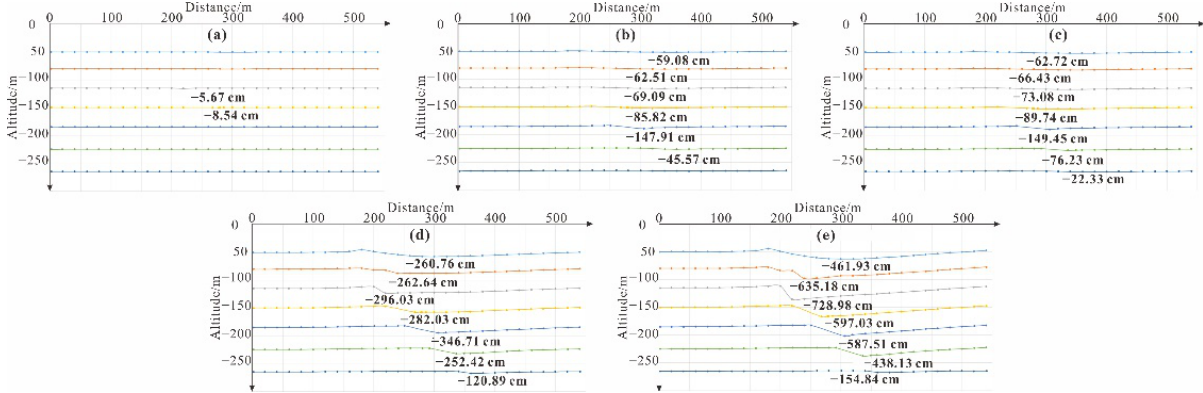
Figure 4. Displacement of surrounding rock during the entire mining process. ( a ) Mining and filling between − 200 m and − 165 m; ( b ) mining and filling between − 240 m and − 205 m; ( c ) mining and filling between − 280 m and − 245 m; ( d ) mining and filling between − 160 m and − 125 m; ( e ) mining and filling between −120 m and −85 m.